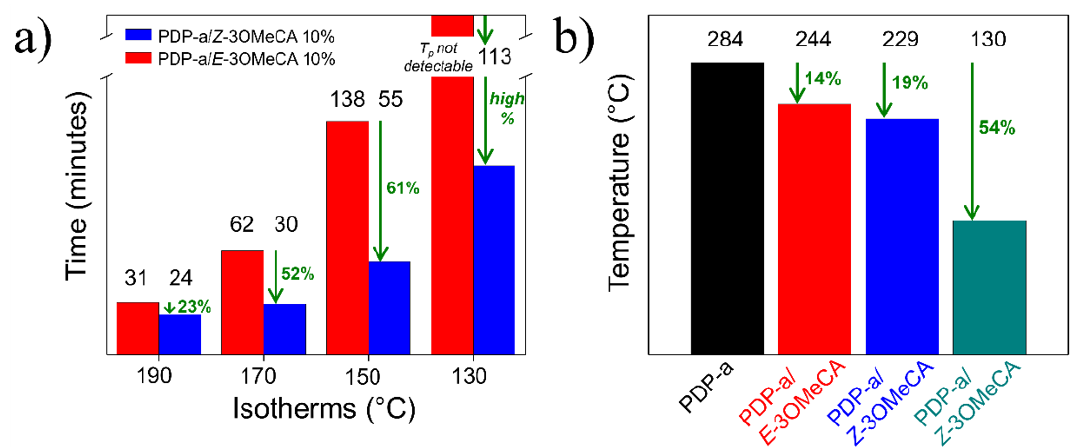
Figure 5. Percentage enhancement (green arrows and values) when comparing: ( a ) time to reach exotherm maxima under each isothermal treatment for systems catalyzed by E -3OMeCA (red bars) and Z -3OMeCA (blue bars); and, ( b ) temperature reduction for uncatalyzed (black bar) and E -3OMeCA (red bar) and Z -3OMeCA (blue bar) catalyzed systems under non-isothermal conditions, and when isothermally catalyzed by Z -3OMeCA (teal bar).